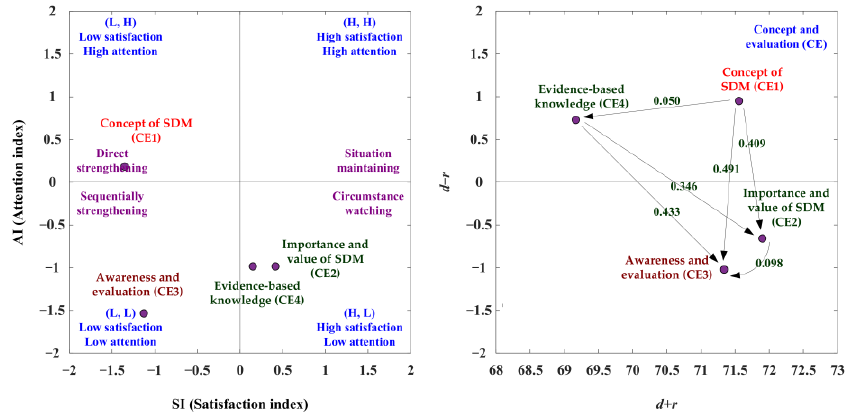
Figure 3. The SDM competency development map for the CE (concept and evaluation) aspect. Table 7. The net influence matrix of the CE (Concept and evaluation) aspect. Criteria CE1 CE2 CE3 Concept of SDM (CE1) - Importance and value of SDM (CE2)